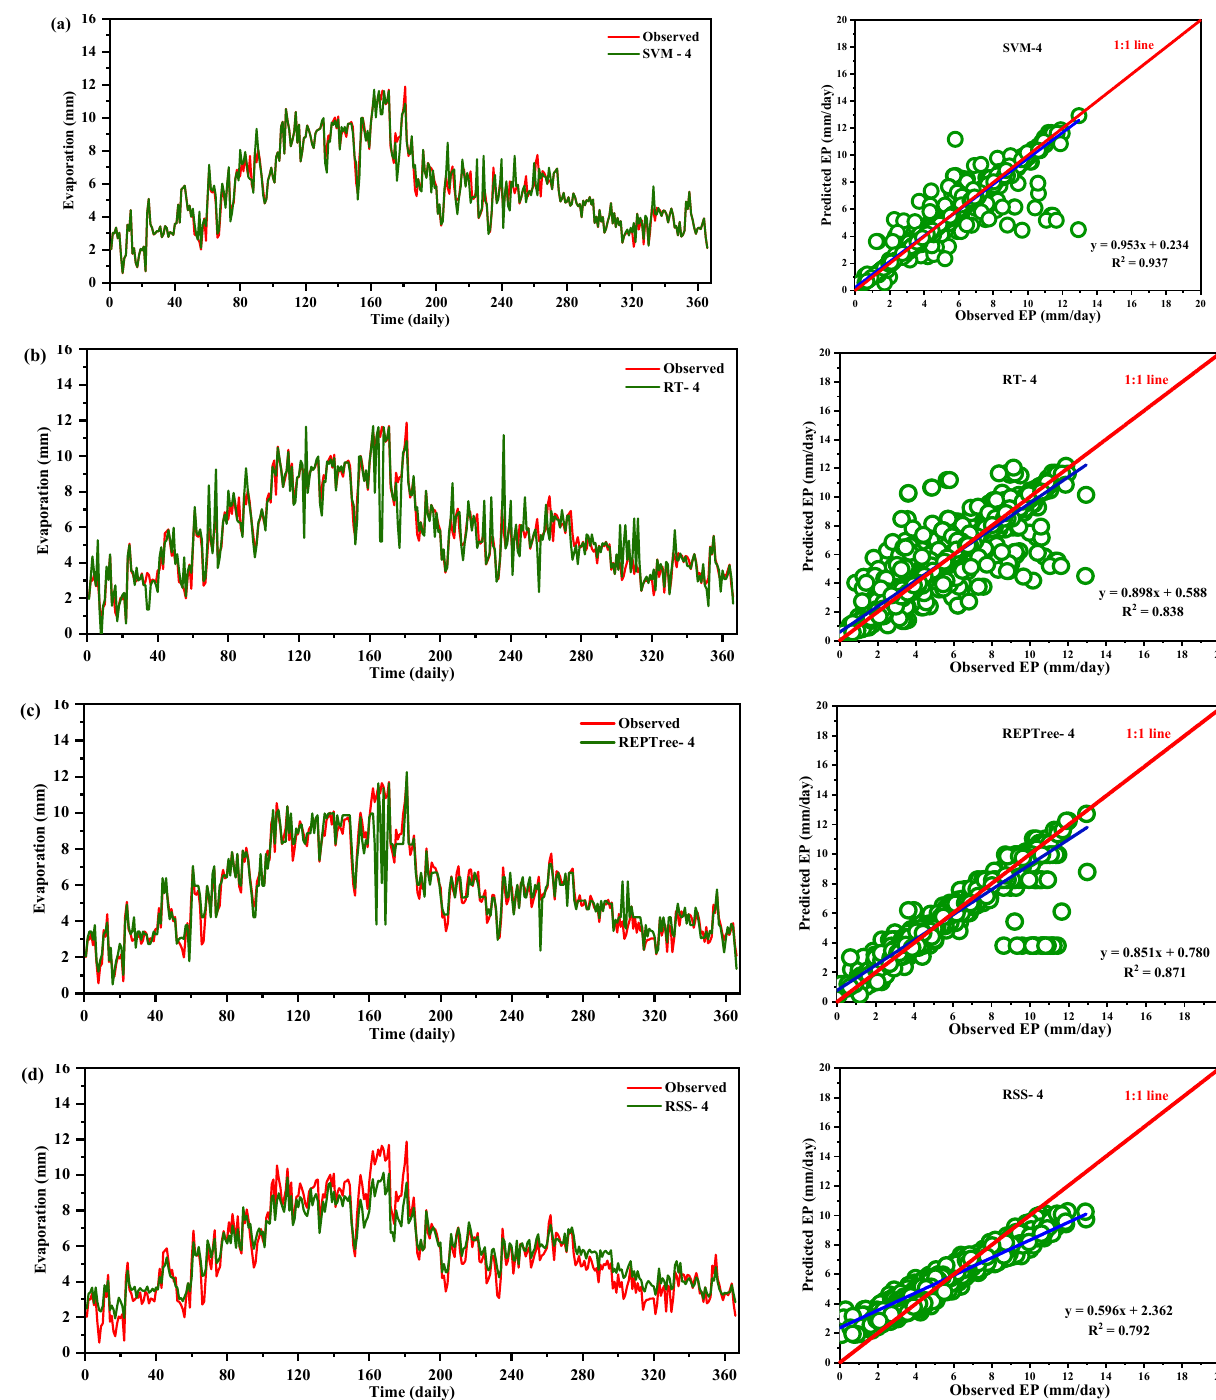
Figure 9. Sample time series plots for 2020 representing observed and modelled evaporation data (left) and scattered plots representing the entire testing dataset (right) of observed vs. estimated EP d values during testing phase at the New Delhi station for ( a ) SVM-4, ( b ) RT-4, ( c ) REPTree-4, and ( d ) RSS-4.